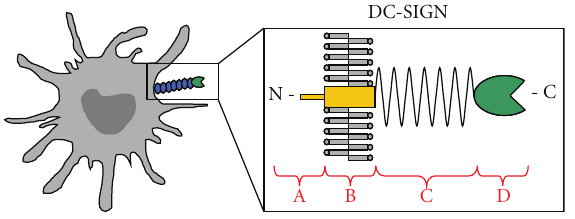
Figure 2: Structure of DC-SIGN. DC-SIGN, mainly expressed by human dendritic cells in the skin, is composed out of four domains: (A) cytoplasmic domain containing internalization signals, (B) transmembrane domain,(C) 7 or 8 extracellular neck repeats impli- cated in the oligomerization of DC-SIGN, and (D) carbohydrate recognition domain which can interact calcium-dependently with a variety of